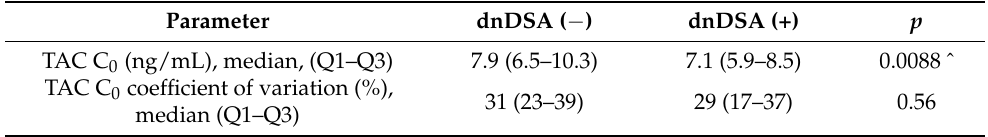
Table 4. Median values and variation of TAC C 0 in all consecutive evaluations between 1st and 24th month after transplantation in the prospective